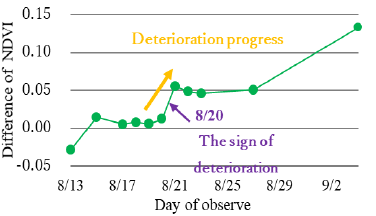
Figure 16. Difference in NDVI in healthy and degraded trees